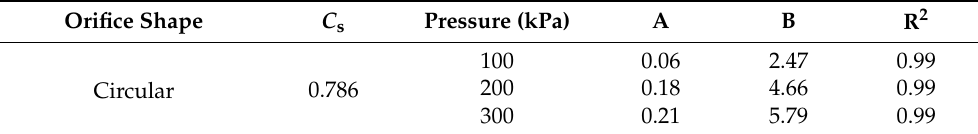
Figure 5. The exponential relationship between droplet size and orifice shapes.